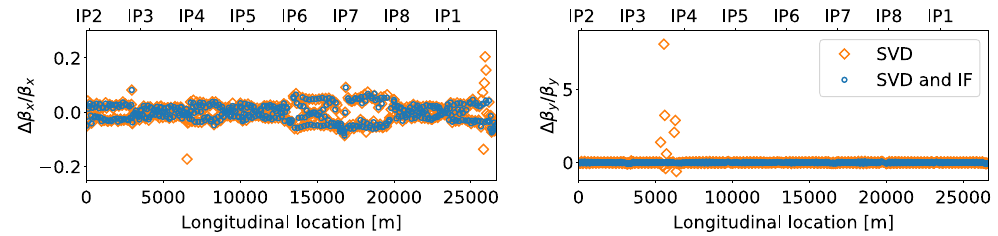
FIG. 3. Comparison between β beating measured from SVD-cleaned data and the data additionally cleaned with IF. The data is obtained during ion commissioning in 2018. Without applying IF nonphysical spikes appear in β beating reconstructed from the BPM